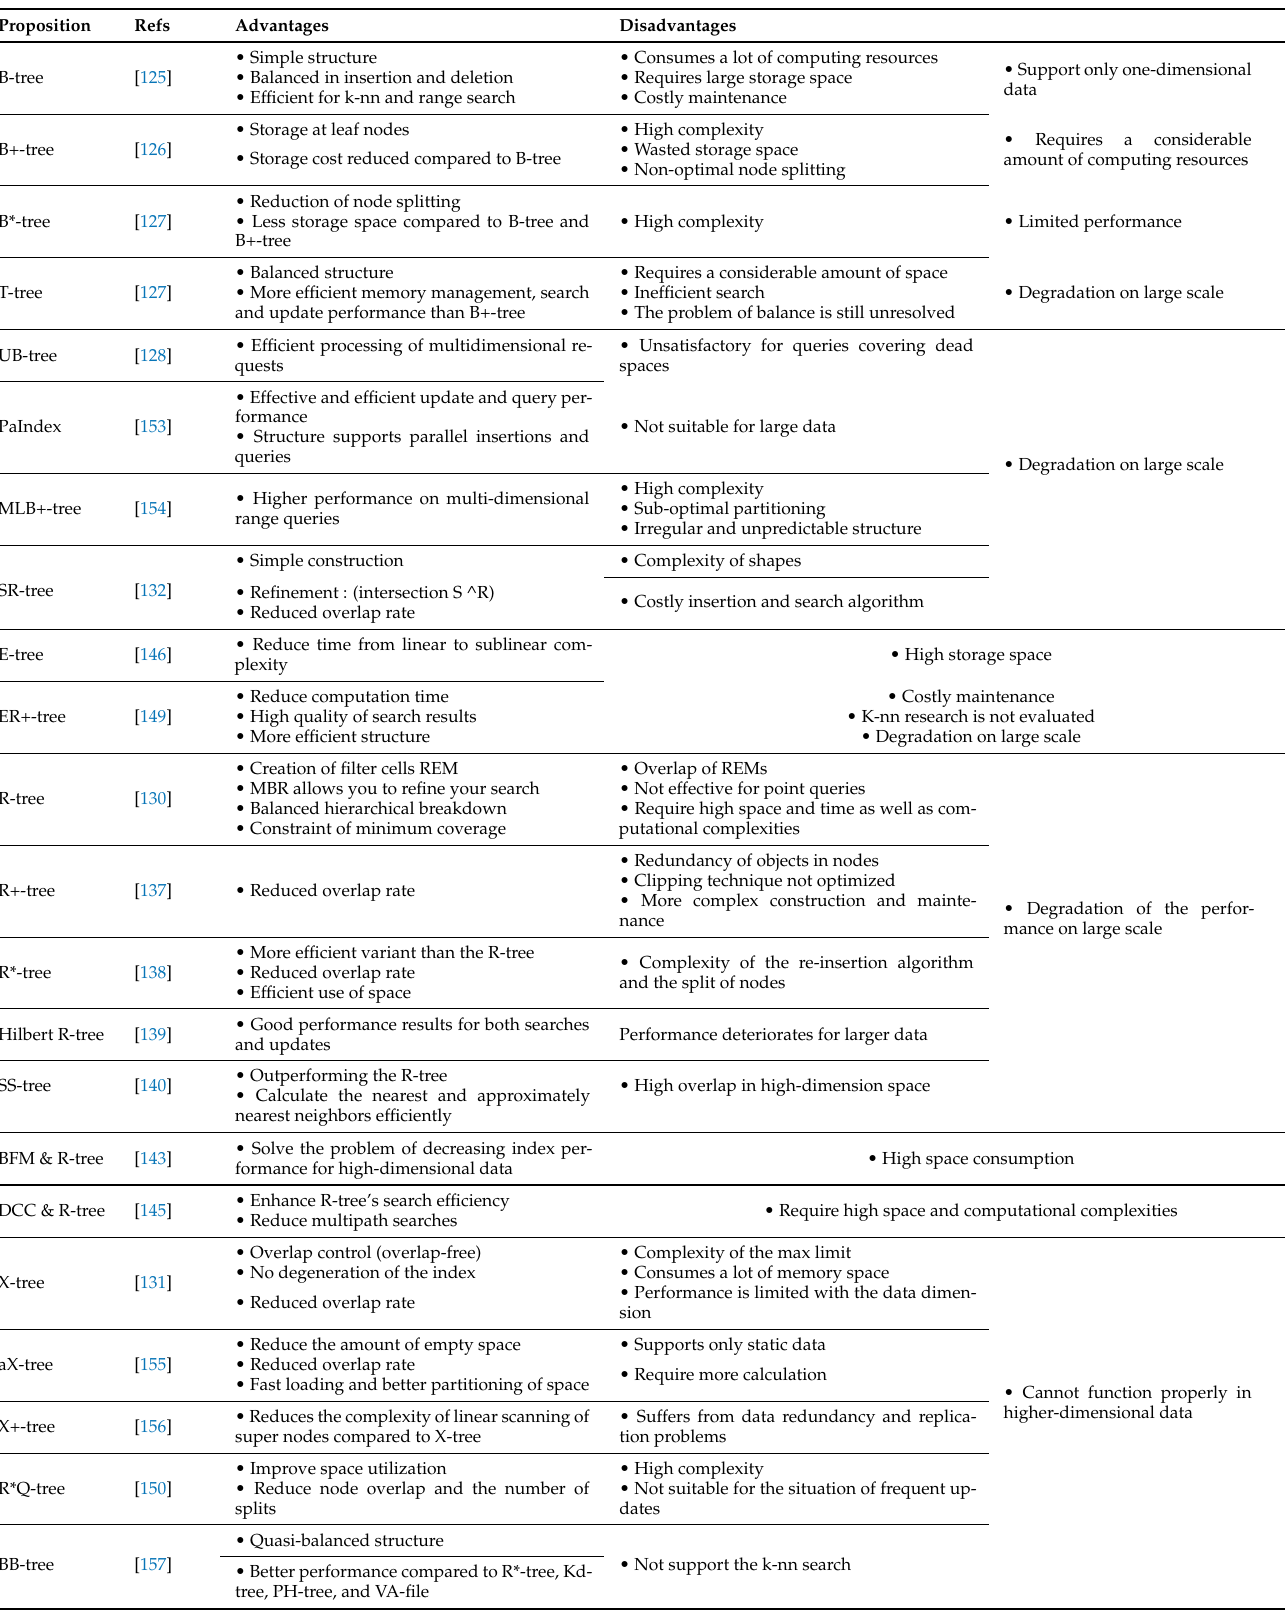
Table 8. Summary of advantage and disadvantage of multidimensional indexing techniques based on data